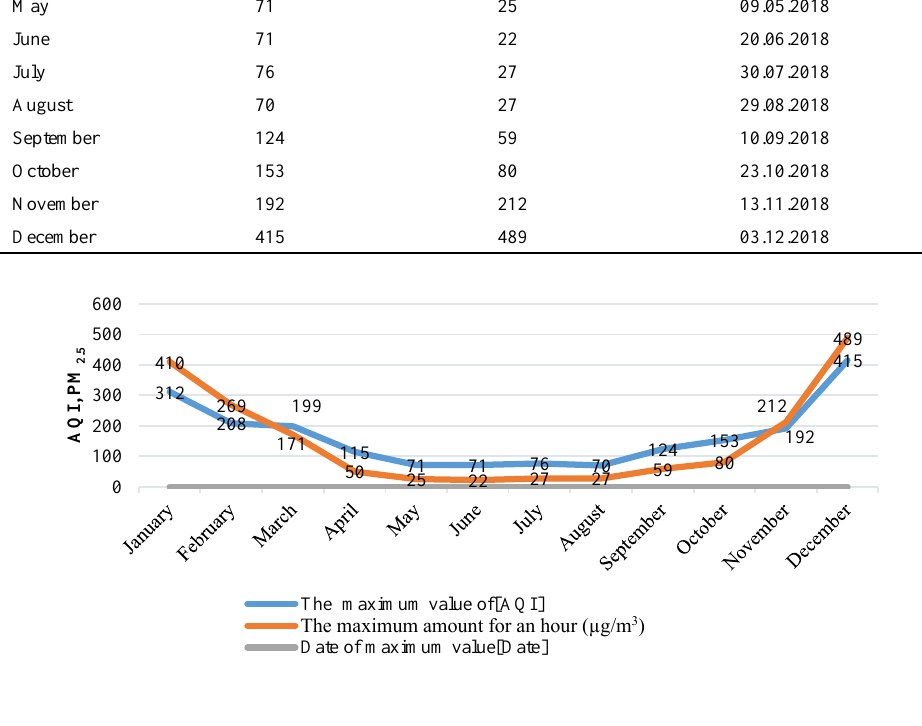
Fig. 3. Chart of measured values for AQI, PM 2.5 in Prishtina,